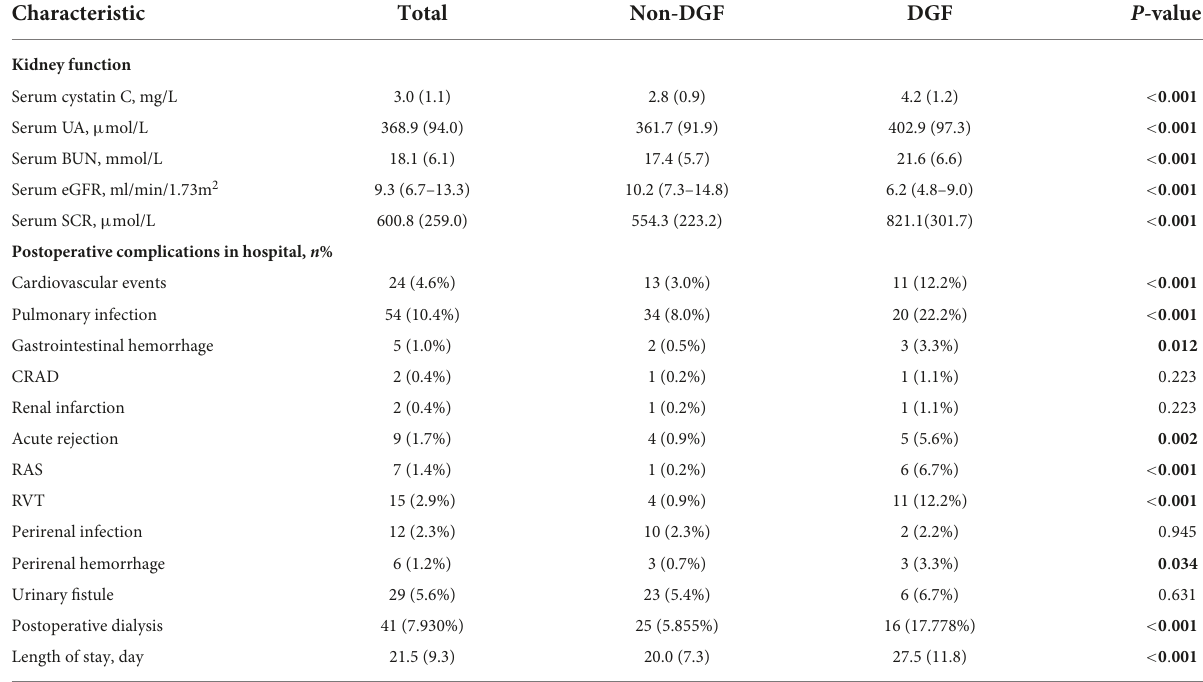
TABLE 3 Renal function on the first day after surgery, postoperative complications while in hospital and length of stay. Characteristic